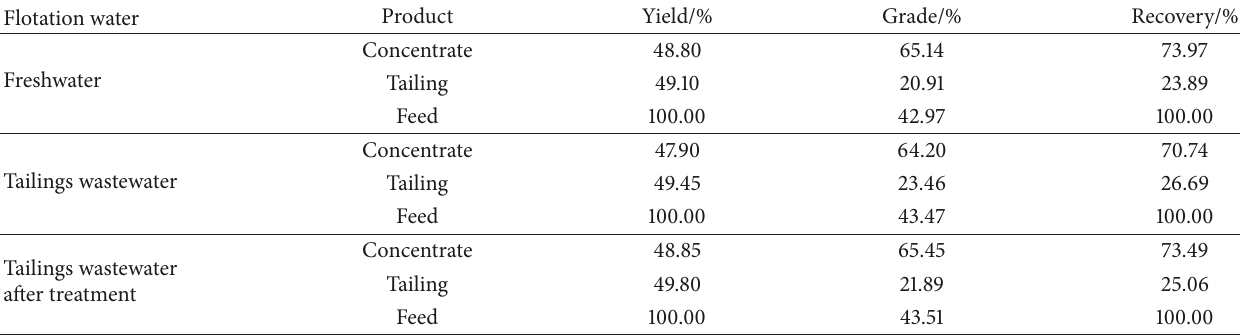
Table 5: The results of oxidation-sedimentation treatment on the reverse flotation of